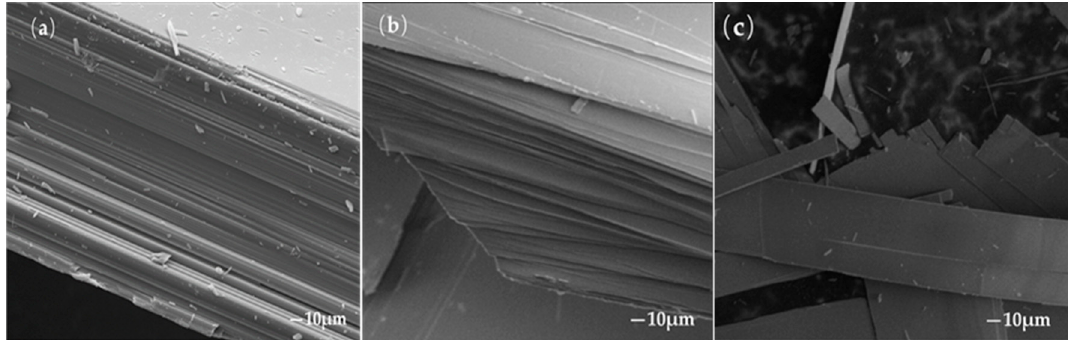
Figure 3. Scanning electron microscopy (SEM) images of the recycled Mo-based products at different ◦ C, ( b ) 200 ◦ C, ( c ) 400 ◦ condensation temperatures ( a ) 25 °C, ( b ) 200 °C, ( c ) 400 °C. condensation temperatures ( a ) 25